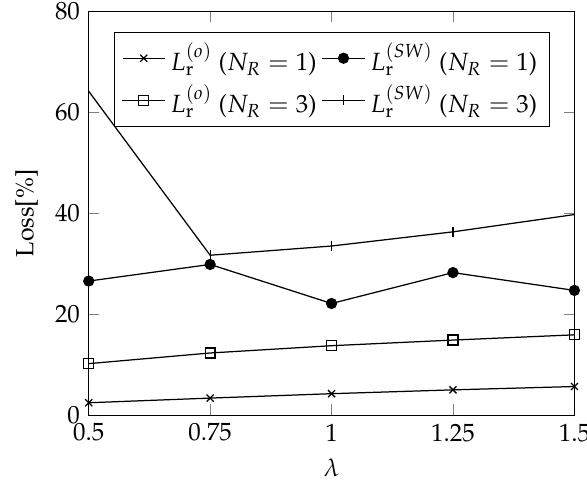
Figure 5. Impact of stickiness on MVNOs’